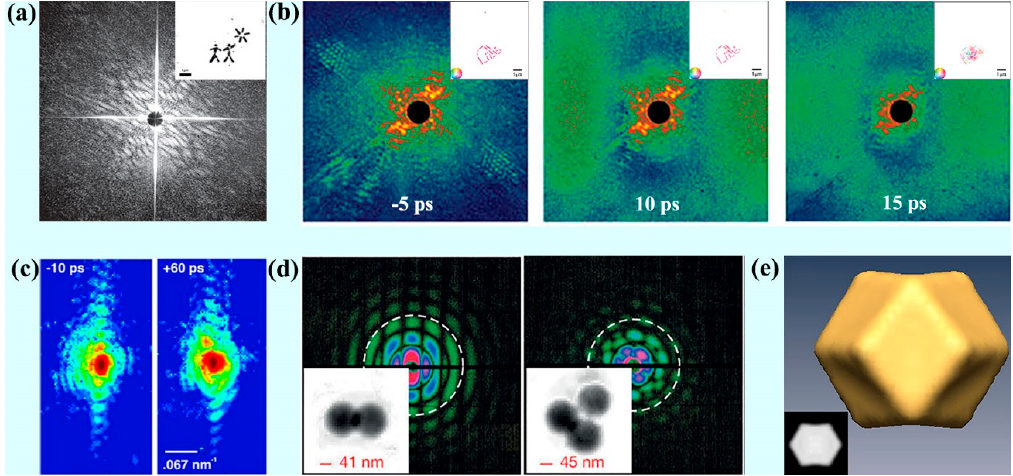
Figure 2. Coherent diffraction imaging of materials with or without pump-probe using X-ray free-electron lasers. ( a ) The first demonstration of coherent diffraction imaging with X-ray lasers at FLASH in 2006. The concept of “diffraction-before-destruction” was demonstrated at the limited resolution available; ( b ) Time-resolved diffractive imaging of a man-made sample. Laser-pump X-ray-probe was applied at different time delays. In this case, the sample is seen to get destroyed under the high pump laser intensity and the features are disappearing after 15 ps; ( c ) Bragg coherent diffraction imaging of gold nanoparticles with hard X-ray lasers was employed at the Linac Coherent Light Source (LCLS). For different time delays, the changes in the diffraction patterns can be used to image phonon dynamics; ( d ) Morphology and chemical components of aerosol particles were captured by coherent diffraction imaging combined with time-of-flight mass spectrometry at LCLS; ( e ) Three-dimensional imaging of nanoparticle from SACLA. By using the symmetry of gold nanoparticles, 48 diffraction patterns were generated. The 3D image was obtained after the finding of common arcs and phase retrieval. The resolution as determined by Fourier shell correlation (FSC) is ~5.5 nm. (Figure 2a was reproduced with permission from [101]. Copyright Springer Nature, 2006. Figure 2b was reproduced with permission from [120]. Copyright Springer Nature, 2008. Figure 2c was reproduced with permission from [128]. Copyright The American Association for the Advancement of Science, 2013.